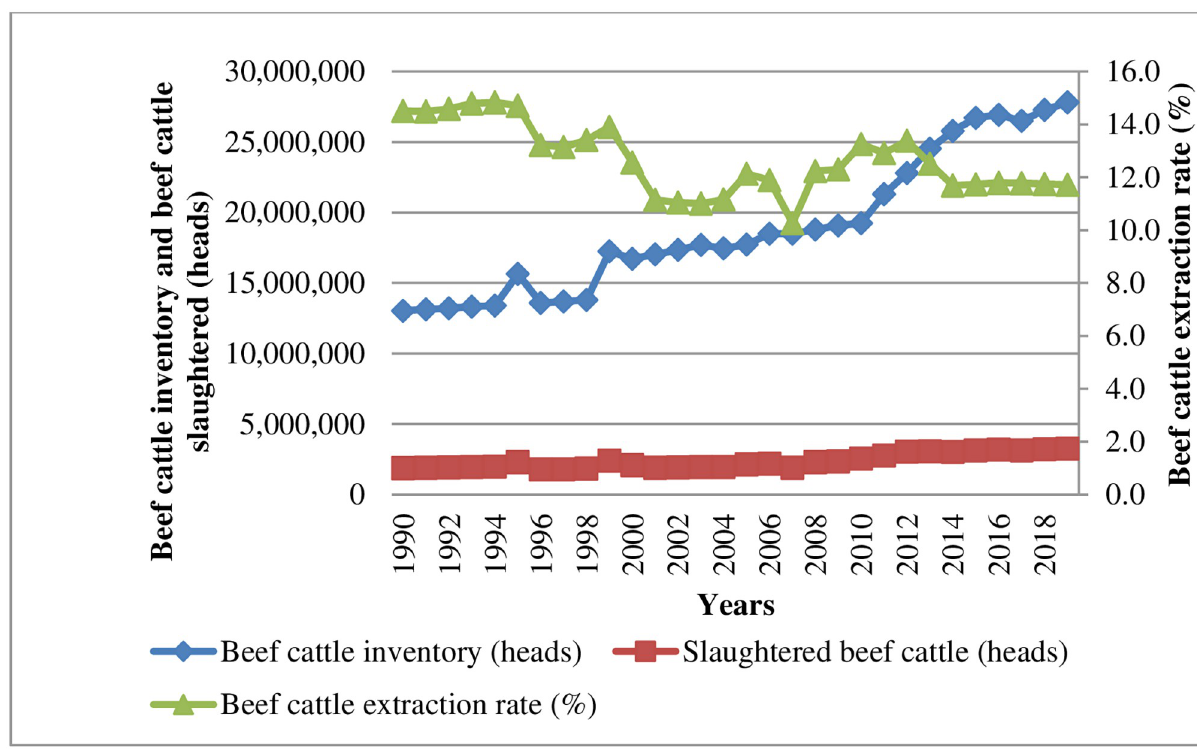
Fig 1. Beef cattle inventory, slaughtered beef cattle, and extraction rate.